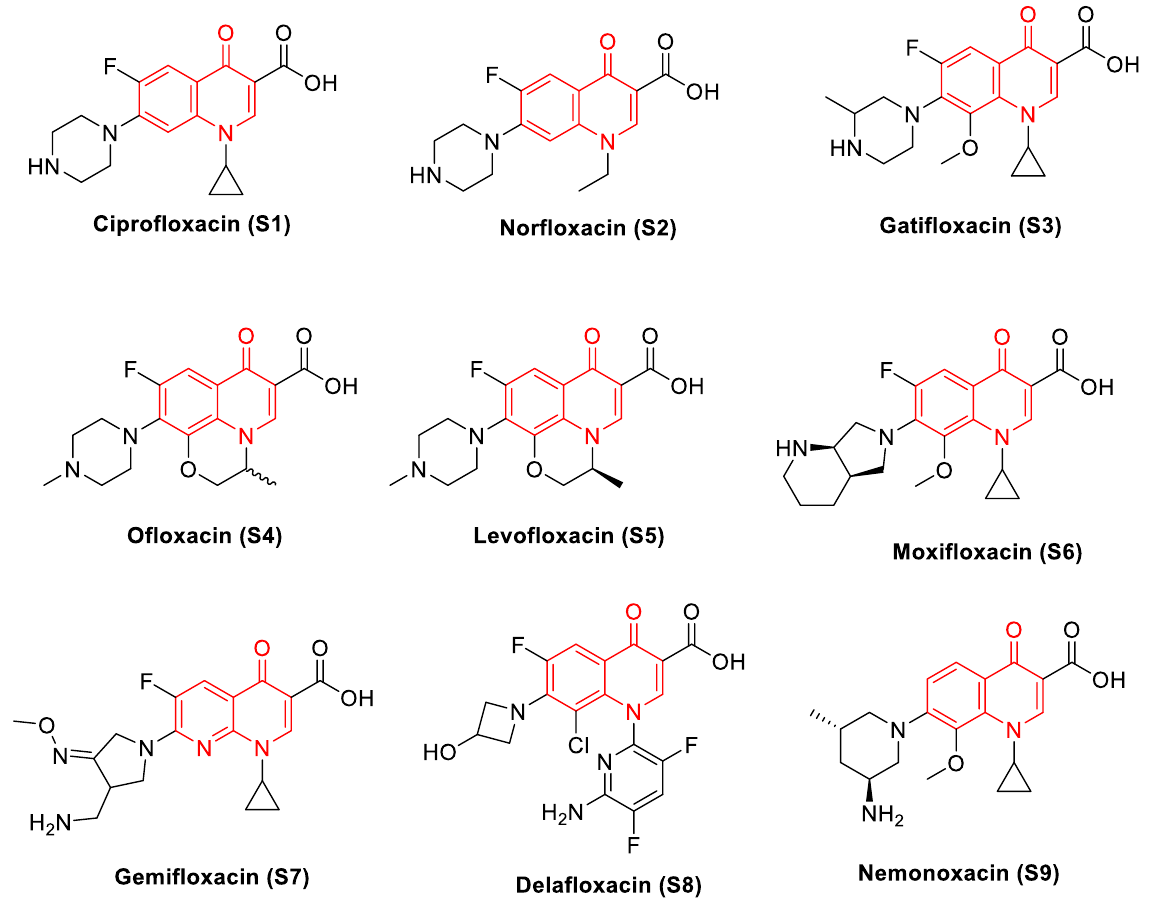
Figure 2. Quinolones (the scaffold colored in red): DNA gyrase poisons used as antibacterial agents.